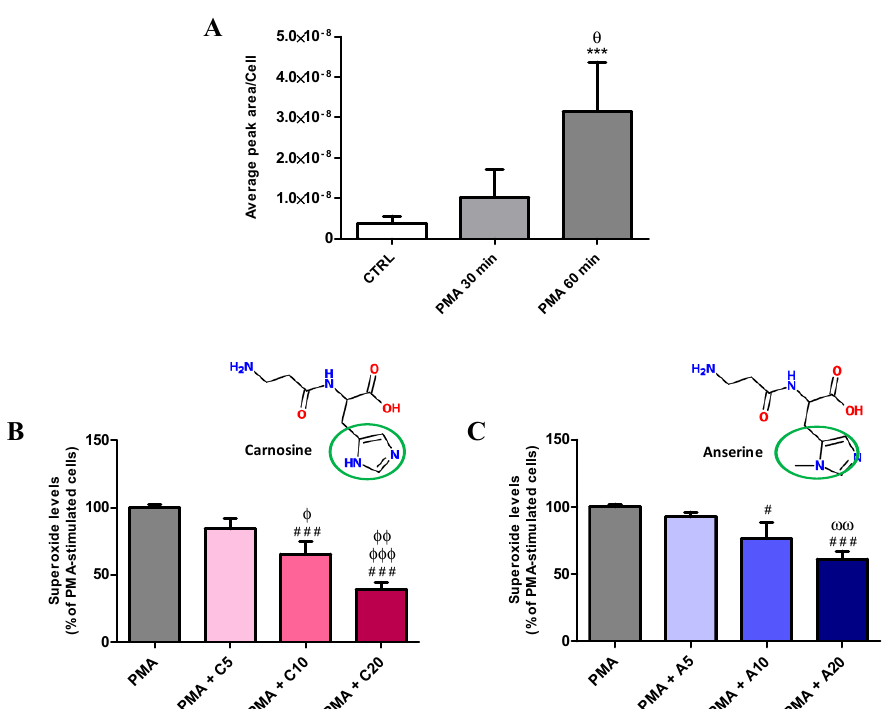
Figure 1. Detection of intracellular concentrations of O 2 − • (as detected by microchip electrophoresis with laser-induced fluorescence (ME-LIF)) in resting (control) macrophages and in macrophages stimulated with phorbol 12-myristate 13-acetate (PMA) and superoxide dismutase (SOD) inhibitors, in absence or presence of increasing concentrations (5, 10, or 20) of carnosine or anserine. ( A ) Change in O 2 − • production (expressed as Average peak area/Cell) in macrophages subjected to two different acute stimulations with PMA. ( B , C ) show the ability of carnosine and anserine in decreasing the intracellular concentrations of O 2 − • PMA-induced, respectively. The O 2 − • levels are expressed as the percent variation with respect to the PMA-stimulated cells. Values are means ± SD of three to five independent experiments. *** p < 0.001 vs. CTRL; θ p < 0.05 vs. PMA 30 min; # p < 0.05 vs. PMA; ### p < 0.001 vs. PMA; ϕ p < 0.05 vs. PMA + C5; ϕϕ p < 0.01 vs. PMA + C10; ϕϕϕ p < 0.001 vs. PMA + C5; ωω p < 0.01 vs. PMA + A5.